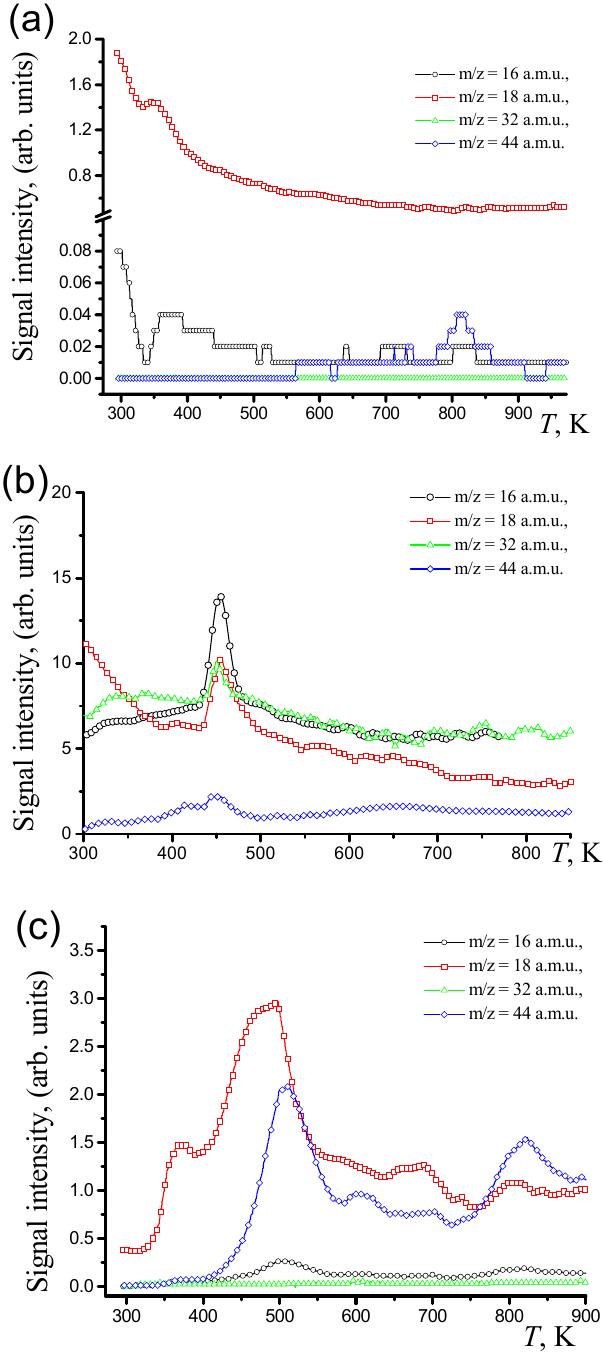
Figure 3. TPD MS profiles of different molecular ions taken after CO conversion to CO for: (a) TEG; (b) CuO/Cu referring to the sample 8